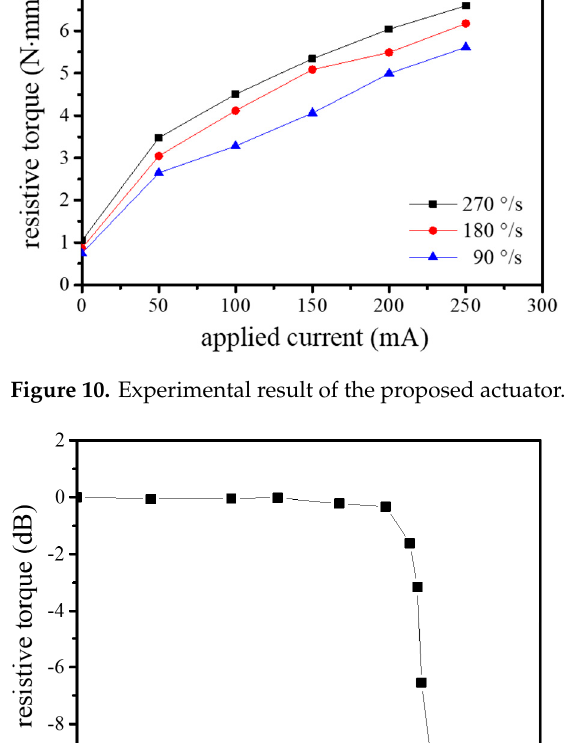
Figure 10. Experimental result of the proposed actuator.